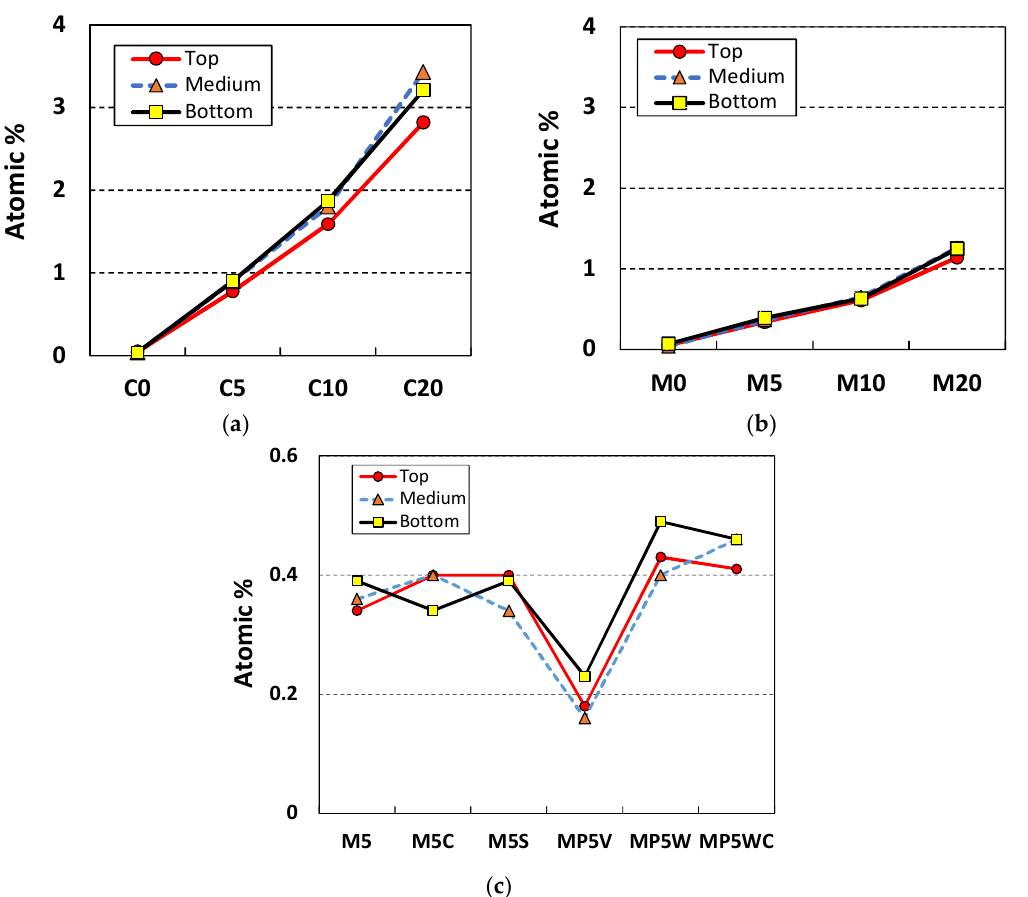
Figure 11. Atomic wt % values of slices of the 5 cm × 10 cm × 1 cm specimens: ( a ) cement paste specimens without compaction; ( b ) mortar specimens without compaction; ( c ) mortar specimens with compaction and sonication.